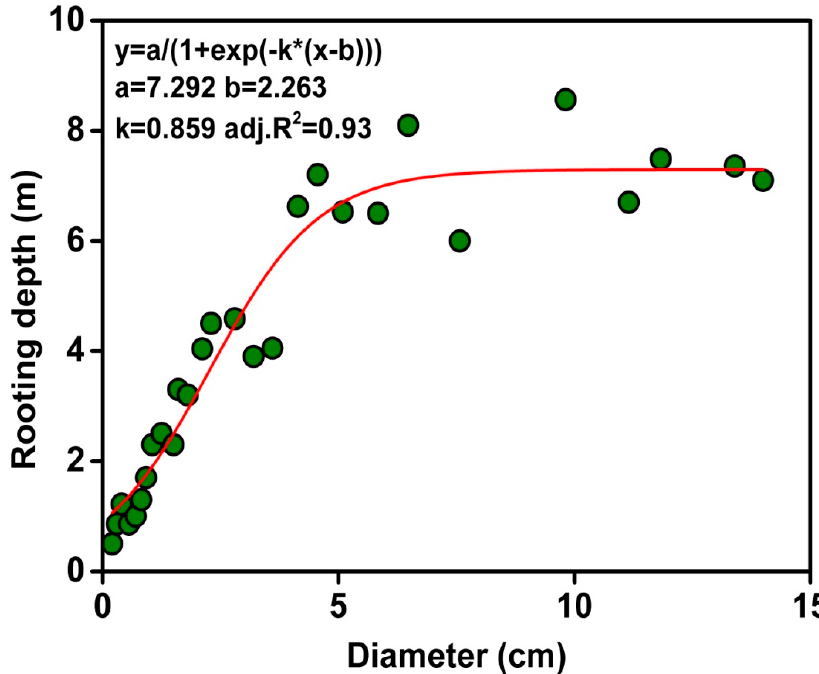
Figure 2. The relationship between rooting depth and basal stem diameter. Data were repotted from